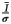
In the balanced state, whole cell balanced amplification functions as a stable and robust linear amplifier.A. For each level of intrinsic excitability (indicated by the color bar) the multiplication factor induced by whole-cell balanced amplification was calculated for different strengths of net synaptic input (I¯σ, x-axis) using Eq 2. We examined the sensitivity of the multiplication factor to the net synaptic current by normalizing it to its mean value (Y -axis). For all intrinsic excitability levels (θσ), indicated by the color bar), the value was close to one, indicating an almost constant multiplication factor. The image above the color bar helps to visualize θσ, by indicating for each value of θσ (and thus for the aligned color) the proportion of the voltage above the threshold when the mean synaptic current was zero. B. The mean multiplication factor (Y-axis) was calculated for each level of intrinsic excitability (θσ, X-axis).